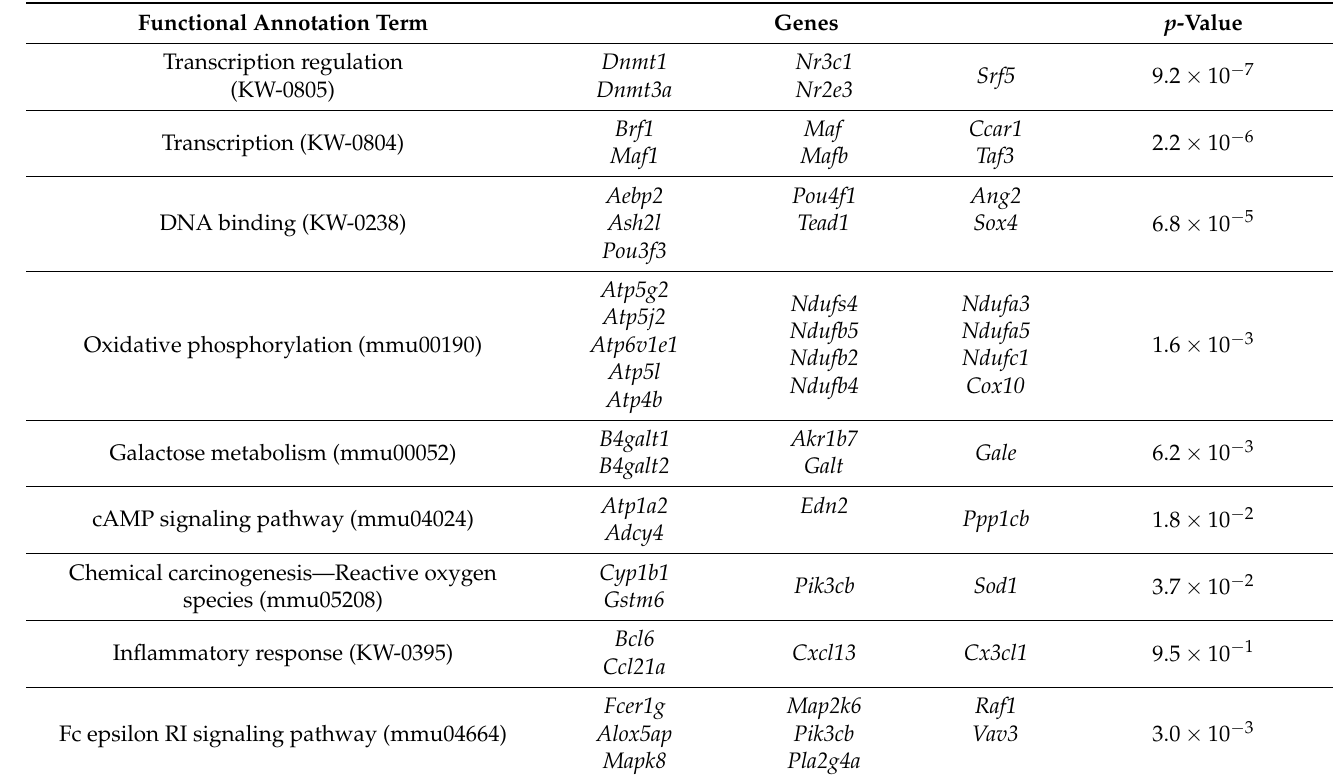
Table 1. Functional enrichment analysis of cyclic hypoxia-related mast cell signature